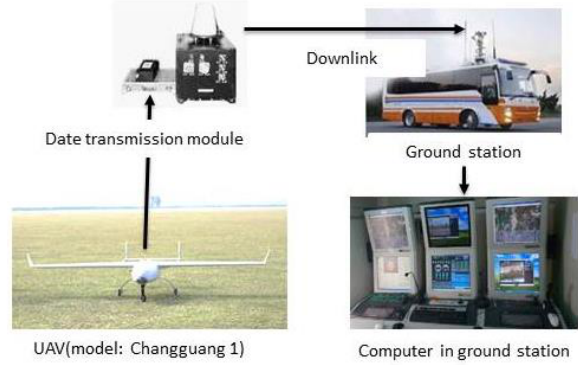
Figure 2. UAV system architecture.